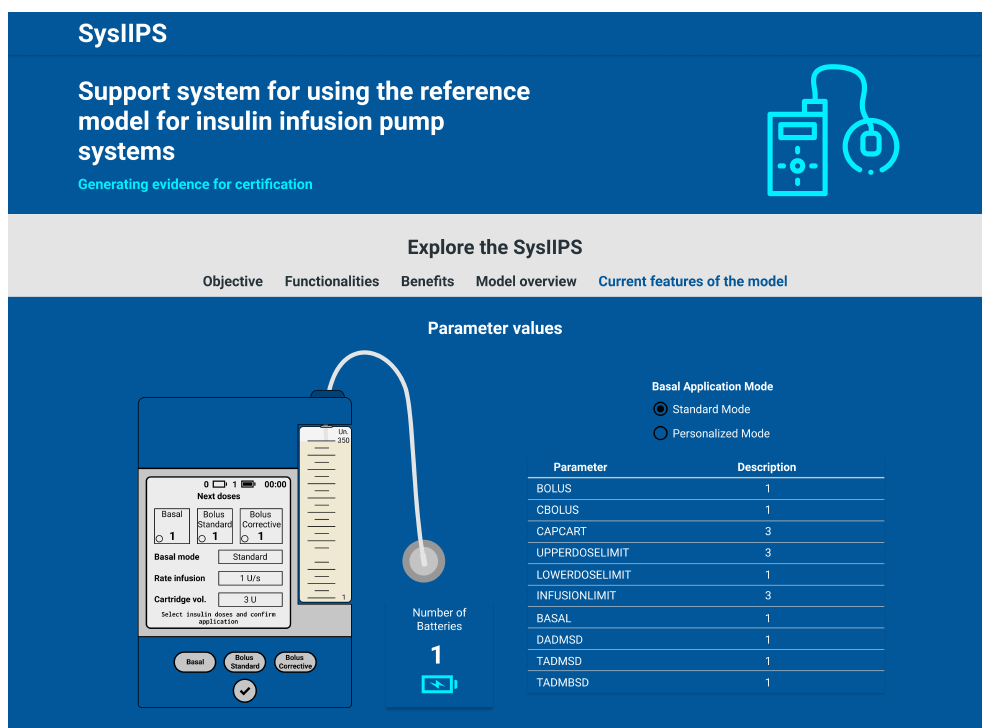
Figure 15. GUI sample of the web-based application presenting main functionalities.